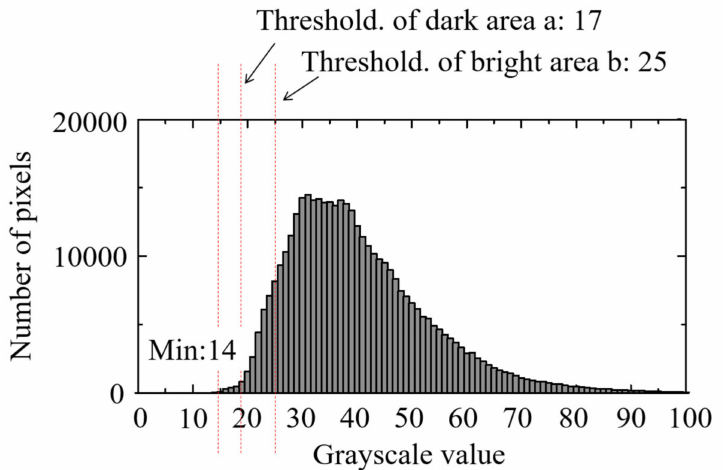
Figure 13. Histogram of standard image (CFRP 5 wt %, BP = 4 MPa, 60 rpm, Shot No.